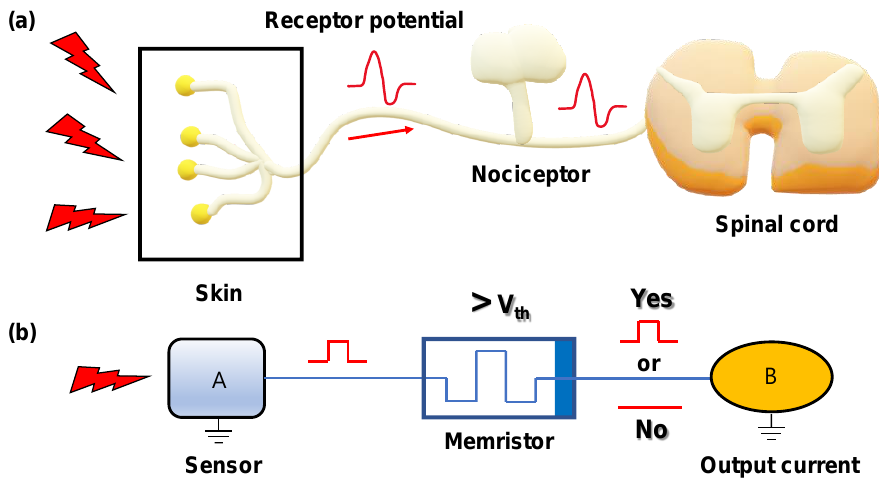
Figure 2. Nociceptor system in a human body and artificial nociceptor circuit using a TS memristor. ( a ) When external stimuli are introduced through the human skin, nociceptor determines the magni- tude of the signal above the threshold and creates a potential to send information to the spinal cord. ( b ) Schematic in which an electrical pulse is applied to the sensor. A pulse higher than the threshold value is applied, the memristor is turned on and an output current is generated.